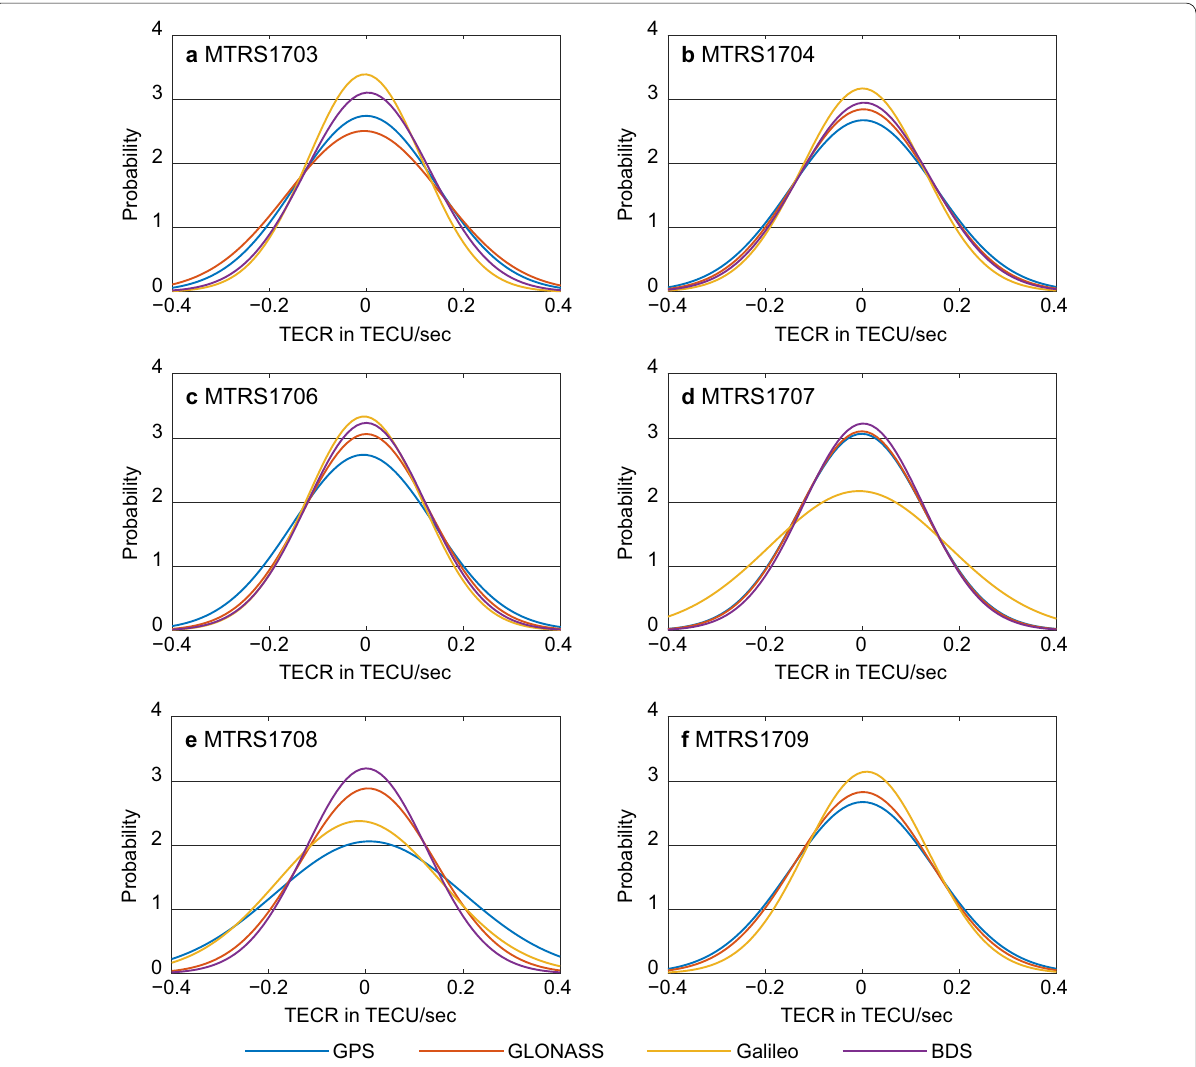
Fig. 13 Probability density functions of the TECR derived from the moving receiver for six travels ( a – f ) . They are calculated from the carrier phase measurements collected at the moving station on the MTR train. The probability density function for BDS in MTRS1709 is not displayed because of inadequate